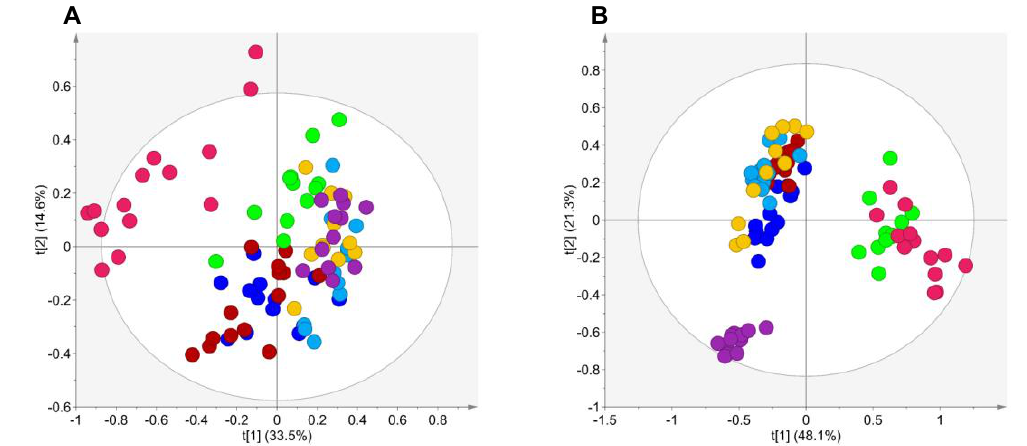
Figure1. Principalcomponent analysis (PCA)scoresscatter plotsobtained for theheadspace solid-phase microextraction (HS-SPME) / gas chromatography–mass spectrometry (GC–MS) chromatogram data of ( A ) volatile organic compounds (VOCs) and ( B ) volatile carbonyl compounds (VCCs) of culture media of HK-2 (green, n = 12), 769-P (dark blue, n = 13), 786-O (red, n = 14), Caki-1 (orange, n = 11), Caki-2 (purple, n = 12), ACHN (light blue, n = 12) and blanks (pink, n =